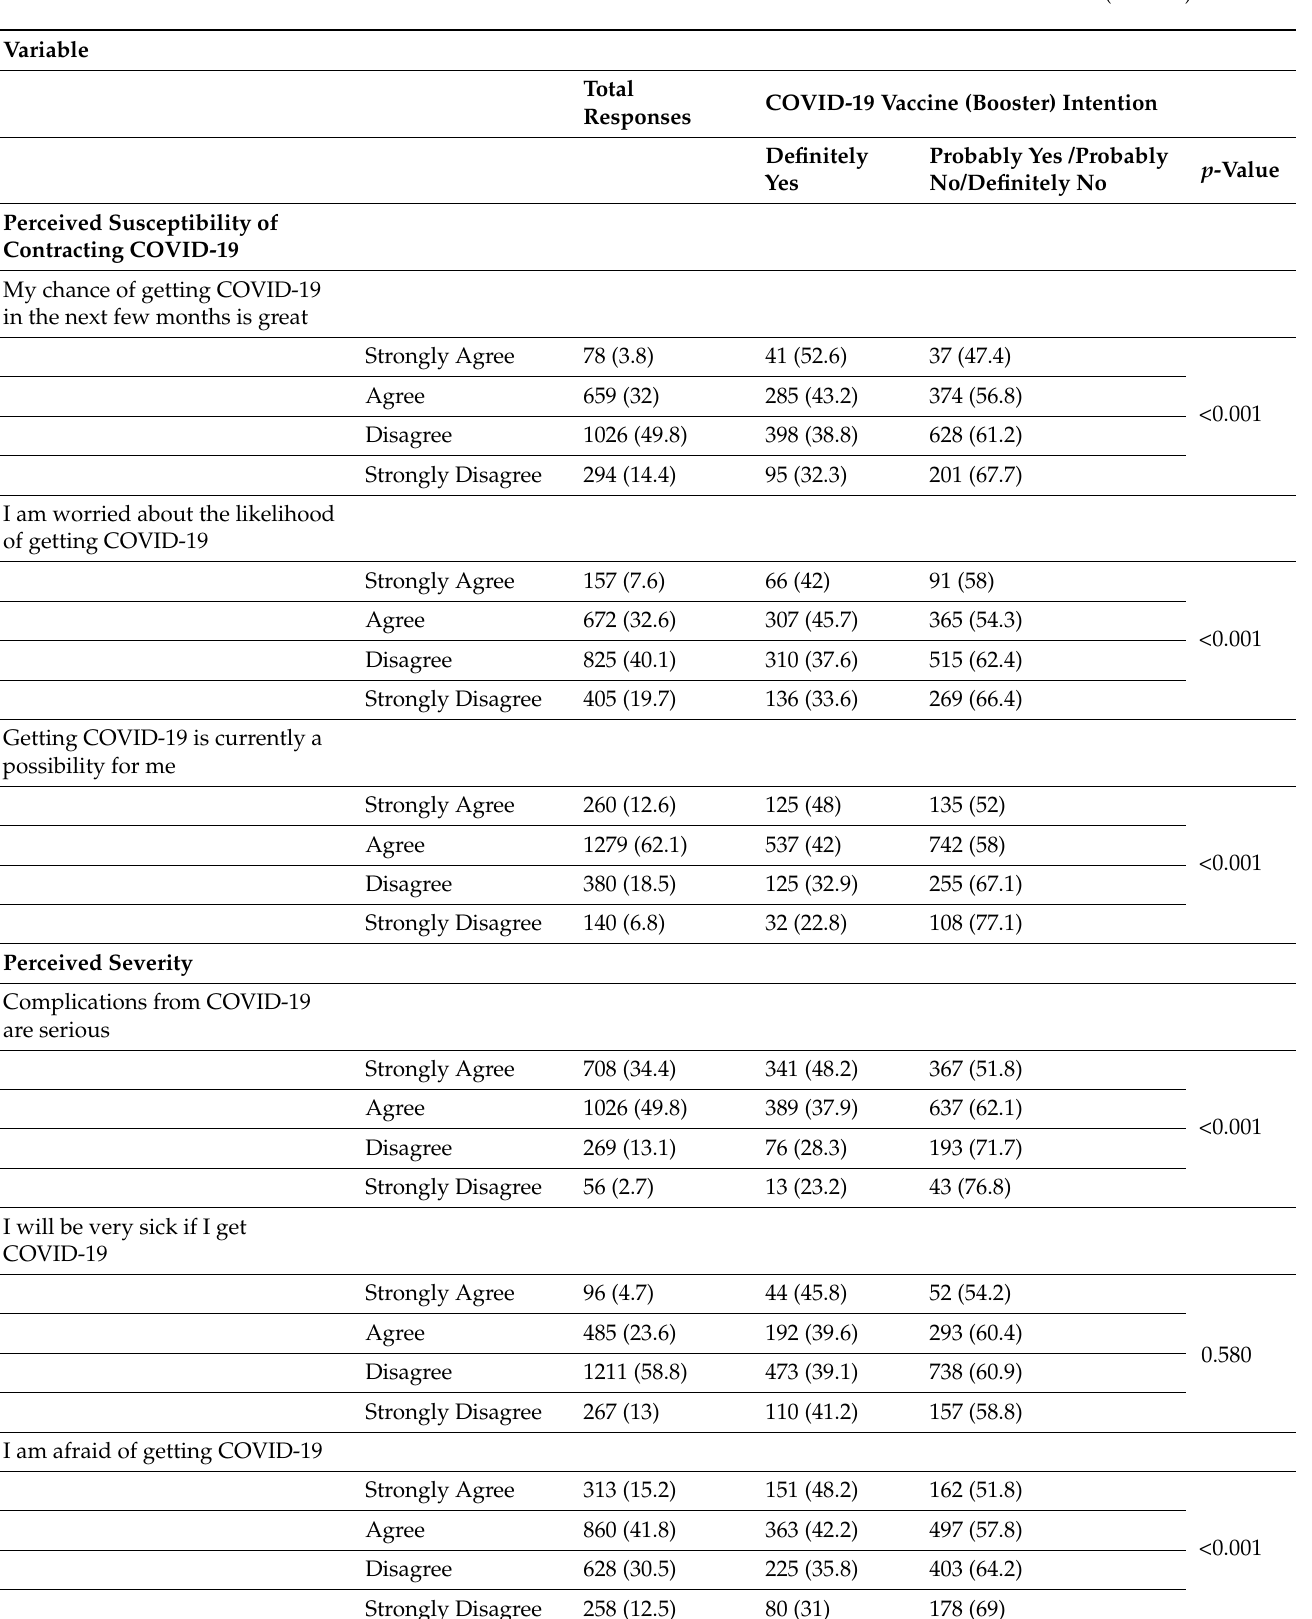
Table 4. Association between HBM variables and COVID-19 vaccine third dose (booster)